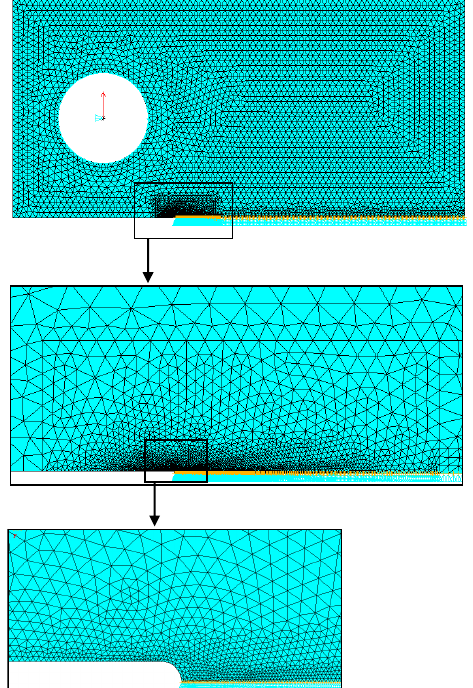
Figure 8: Typical finite element mesh of the CT specimen, using 6-noded quadratic triangular plane stress